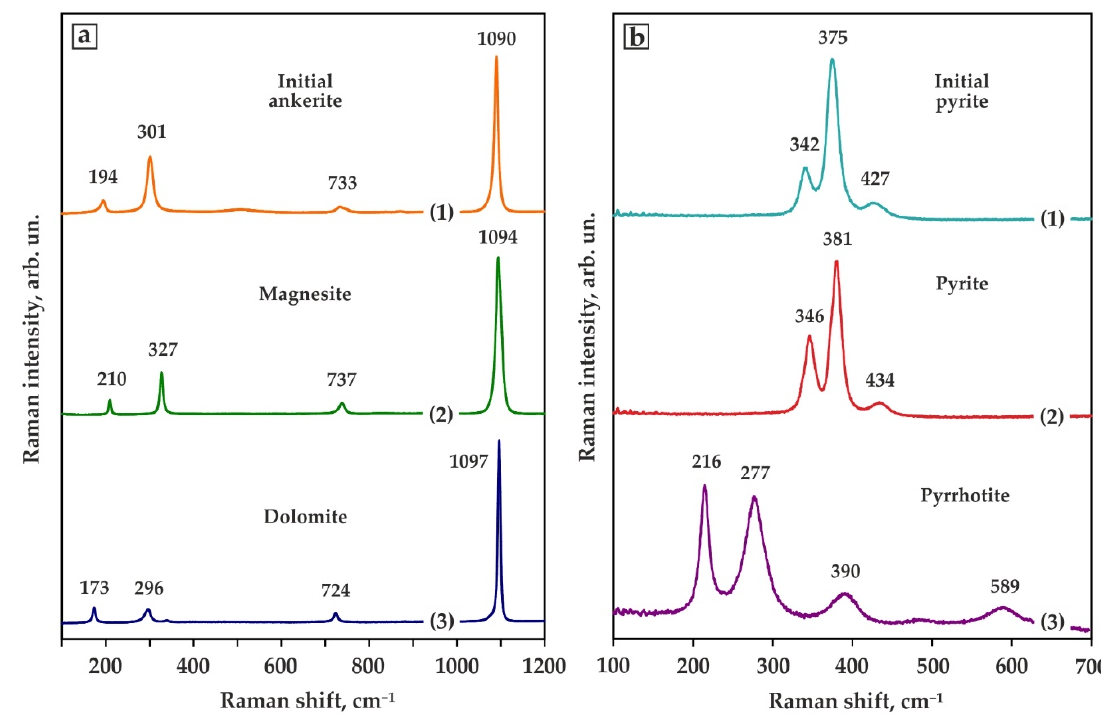
Figure 6. Representative Raman spectra: ( a ) initial natural ankerite (1), newly formed magnesite (1150 ◦ C) (2), and newly formed dolomite (1350 ◦ C) (3); ( b ) initial natural pyrite (1), recrystallized pyrite (1050 ◦ C) (2), and newly formed pyrrhotite (1250 ◦ C) (3). arb. Un—arbitrary unit.